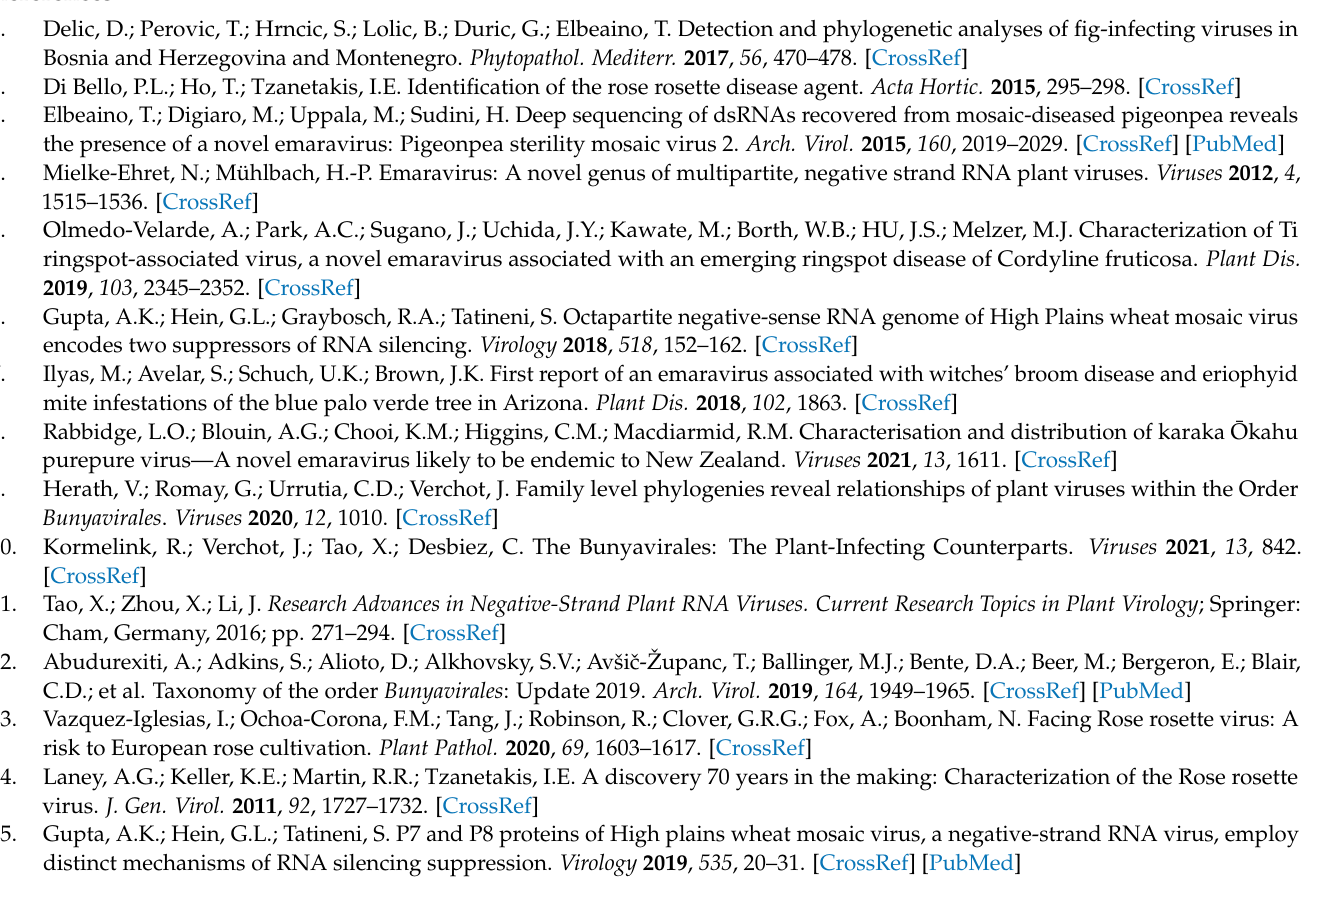
Figure S3: Brief (A) Nt and (B) protein alignments of the RRV R3 and N proteins, respectively, for several isolates; Figure S4: Primer optimization for qPCR amplification of cDNA for agR5-GFP ampli- fication; Figure S5: Primer optimization for qPCR amplification of cDNA for gR5GFP amplification. Table S1: Primer sequences; Table S2: I-Tasser modeling results for polymerase